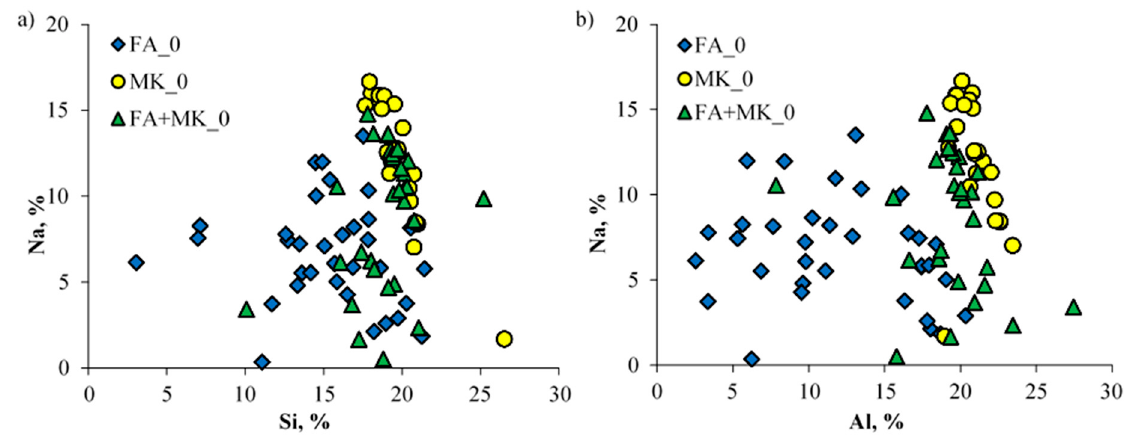
Figure 8. The analysis of pAAM by EDX, correlations between ( a ) Na and Si amount of each spectra; ( b ) Na and Al amount of each ( b ) Na and Al amount of each spectra.